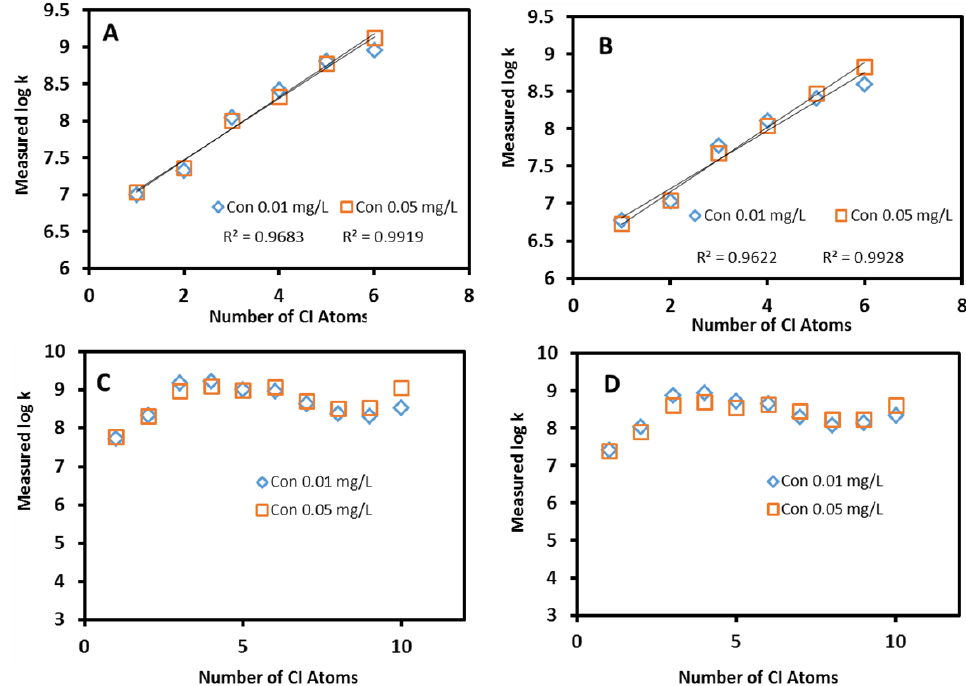
Figure 8. Effect of the concentrations of aromatic organochlorines on their adsorption onto ZnO NPs. Adsorption coefficients of chlorobenzenes at concentrations of 0.01 and 0.05 mg/L with a concentration of ZnO NPs of 0.1 mg/L ( A ) or 0.2 mg/L ( B ). Adsorption coefficients of PCBs at concentrations of 0.01 and 0.05 mg/L with a concentration of ZnO NPs of 0.1 mg/L ( C ) or 0.2 mg/L ( D